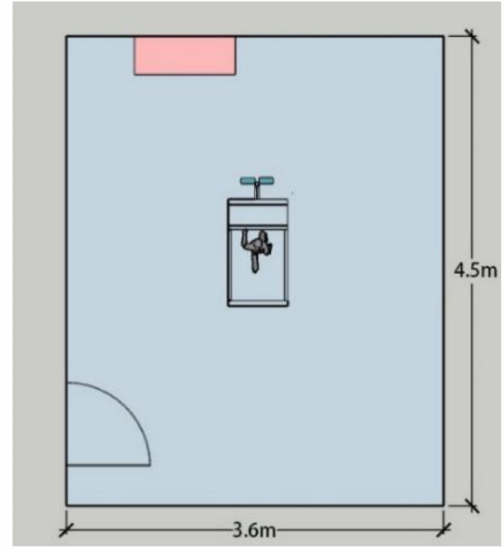
Figure 1. Climatic chamber